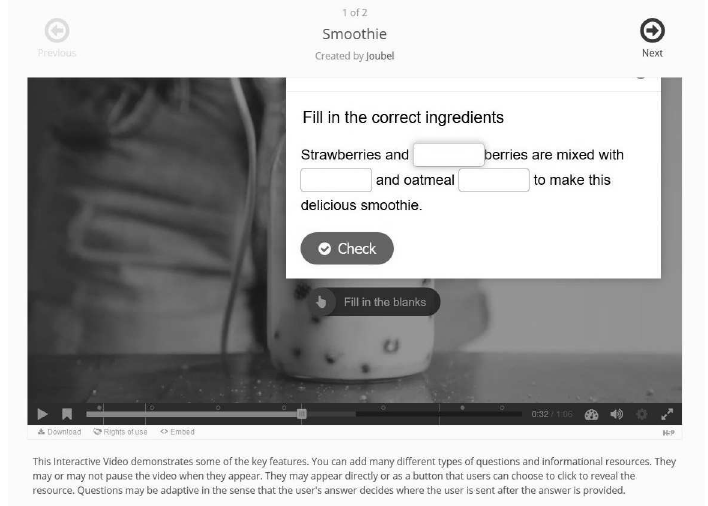
Figure 3. Resources with embedded quizzes or links to pages with